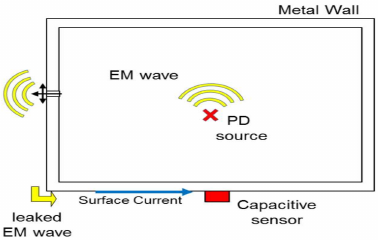
Figure 1. Mechanism of generation and detection of transient earth